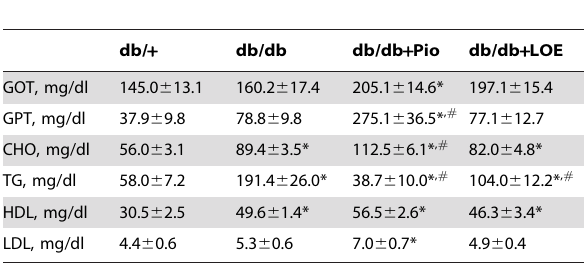
Table 2. Effect of LOE and pioglitazone on metabolic parameters in plasma of db/db mice.